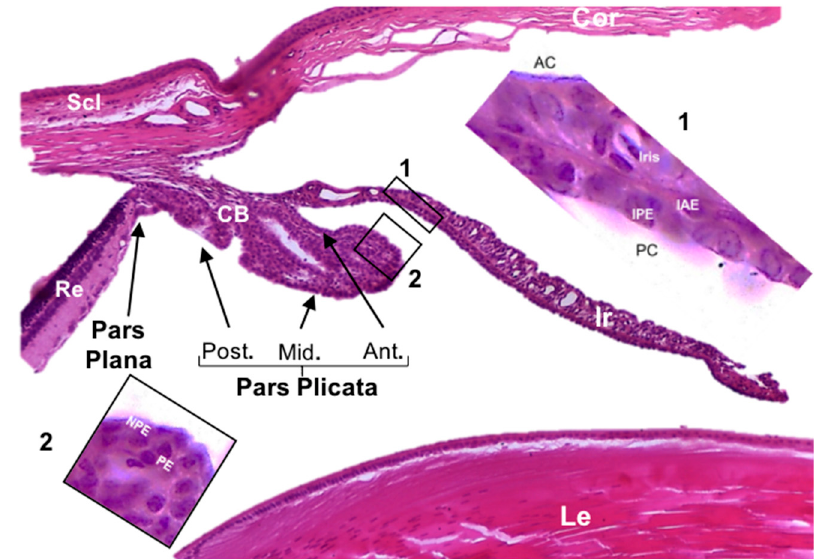
Figure 1. Hematoxylin-eosin stains on the rat eye indicating the ciliary body and iris structures. AC: anterior chamber; CB: ciliary body; Cor: cornea; IAE: iris anterior epithelium; IPE: iris posterior epithelium; Ir: iris; Le: lens; PC: posterior chamber; Re: retina; Scl: sclerotic.